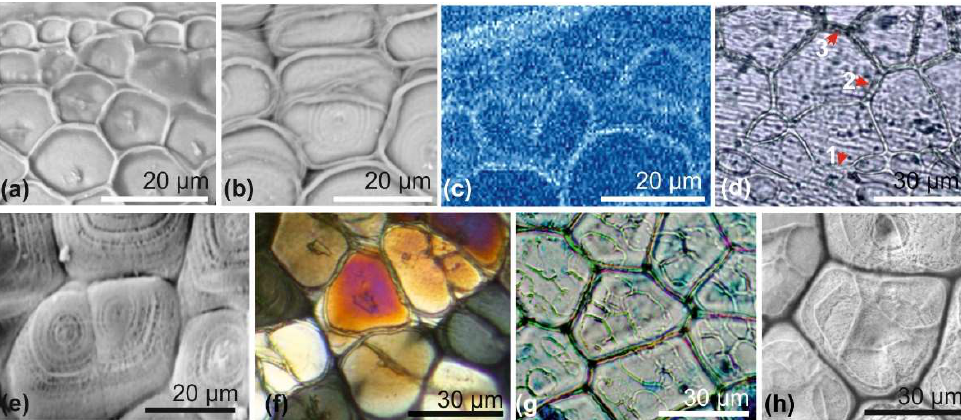
Figure 4. First step of the formation of the rigid shell of Pinctada . ( a , b ) SEM view of the periostracal units close to the end of their transit within the outer mantle grove; each is surrounded by an organic peripheral bulge formed by the mineralizing gel secreted by the mantle grove epithelium. ( c ) Synchrotron X-ray fluorescence shows evidence of Zn concentration in the individual bulge of the discs; see also Figure A4. ( d ) Beginning and progressive thickening (arrows 1 to 3) of the polygonal organic framework (Alcian Blue staining, decalcified preparation, transmitted light). Note in the background the parallel striation due to the pulsed periostracal growth. ( e ) Example of inclusion of two periostracal units (note their concentric individual development). ( f ) Transmitted polarized light. ( g ) Alcian Blue staining decalcified, transmitted light. Note the remains of the periostracal units inside polygons. ( h ) SEM view of an equivalent area. The calcified surface still bears the remains of the previous growth stage.